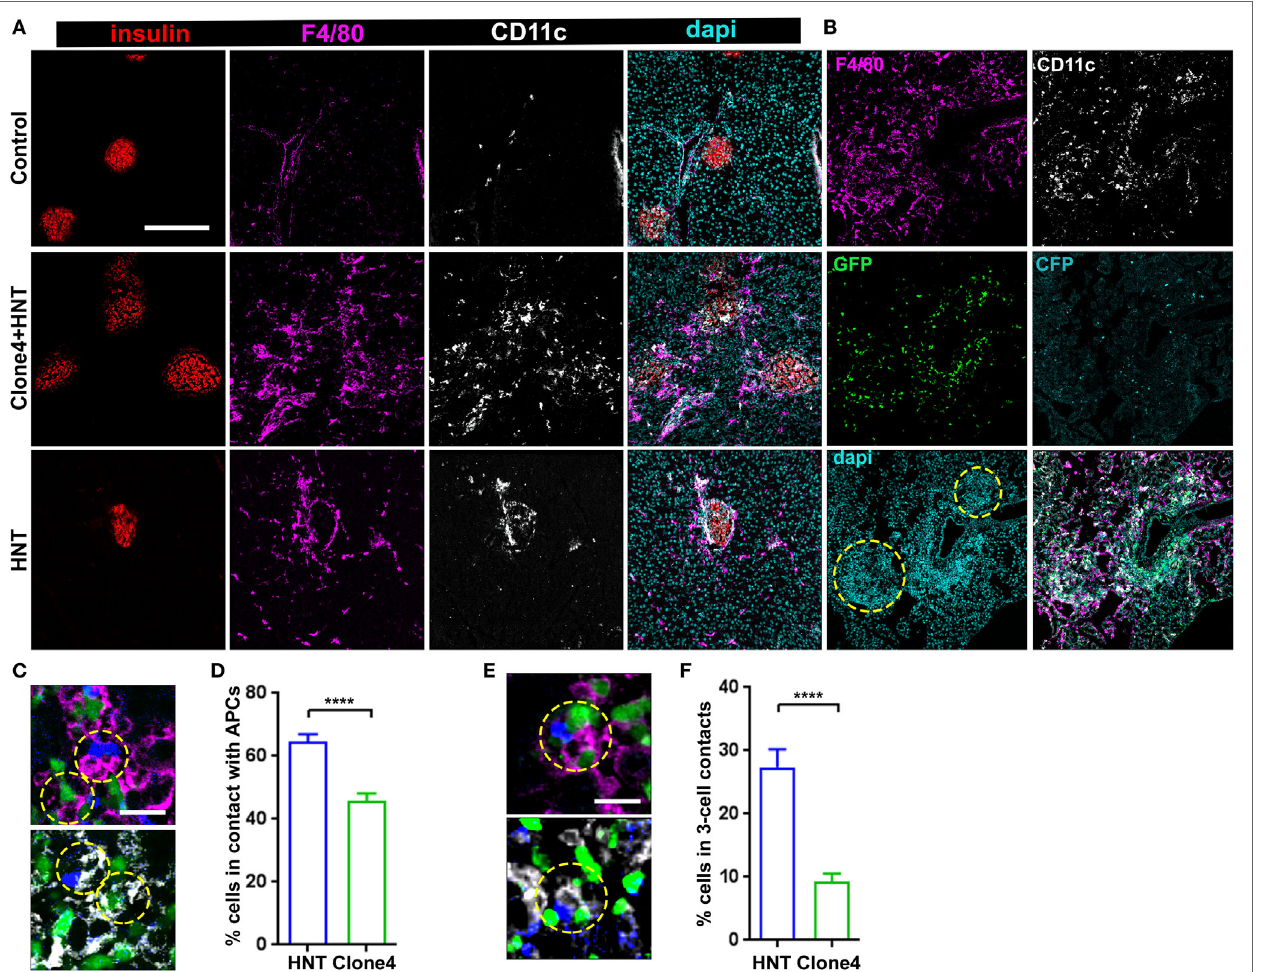
FigUre 2 | Islet antigen-specific CD4 + T cell arrest correlates with localized recruitment of myeloid cells at infiltration sites. (a) Representative confocal images of pancreas from irradiated non-transferred, irradiated co-transferred with clone 4-GFP CD8 + and HNT-CFP CD4 + , and irradiated transferred with HNT-CFP CD4 + InsHA-mCherry mice at day 8 posttransfer stained with the indicated mAbs (scale: 200 µm, Z-projection of 10 µm). (B) Representative confocal images of the pancreas from an irradiated InsHA-mCherry mouse at day 8 posttransfer of HNT-CFP CD4 + and clone 4-GFP CD8 + T cells (scale: 200 µm, Z-projection of 6 µm). Islets identified by dense DAPI staining are circled. (c) Representative confocal images of pancreas from mice described in (B) at day 8 posttransfer (scale 20 µm, single Z-plane) depicting HNT-CFP CD4 + (blue) and clone 4-GFP CD8 + (green) cells in contact with an F4/80 + (purple, top) or CD11c + (white, bottom) cell. Cells in contact are circled. (D) Percentage of HNT-CFP CD4 + and clone 4-GFP CD8 + T cells in contact with F4/80 + and CD11c + cells in the exocrine tissue ( n = 3 mice, P < 0.0001, Mann–Whitney U -test). (e) Representative confocal images of pancreas from mice described in (B) at day 8 posttransfer (scale 20 µm, single Z-plane) depicting a three-cell contact (HNT/APC/clone 4) with a F4/80 + (purple, top) or CD11c + (white, bottom) cell. Cells in contact are circled. (F) Percentage of HNT-CFP CD4 + and clone 4-GFP CD8 + T cells forming three-cell contacts with CD11c + APCs in exocrine tissue ( n = 3 mice, P < 0.0001, Mann–Whitney U -test). Values are represented as mean ±